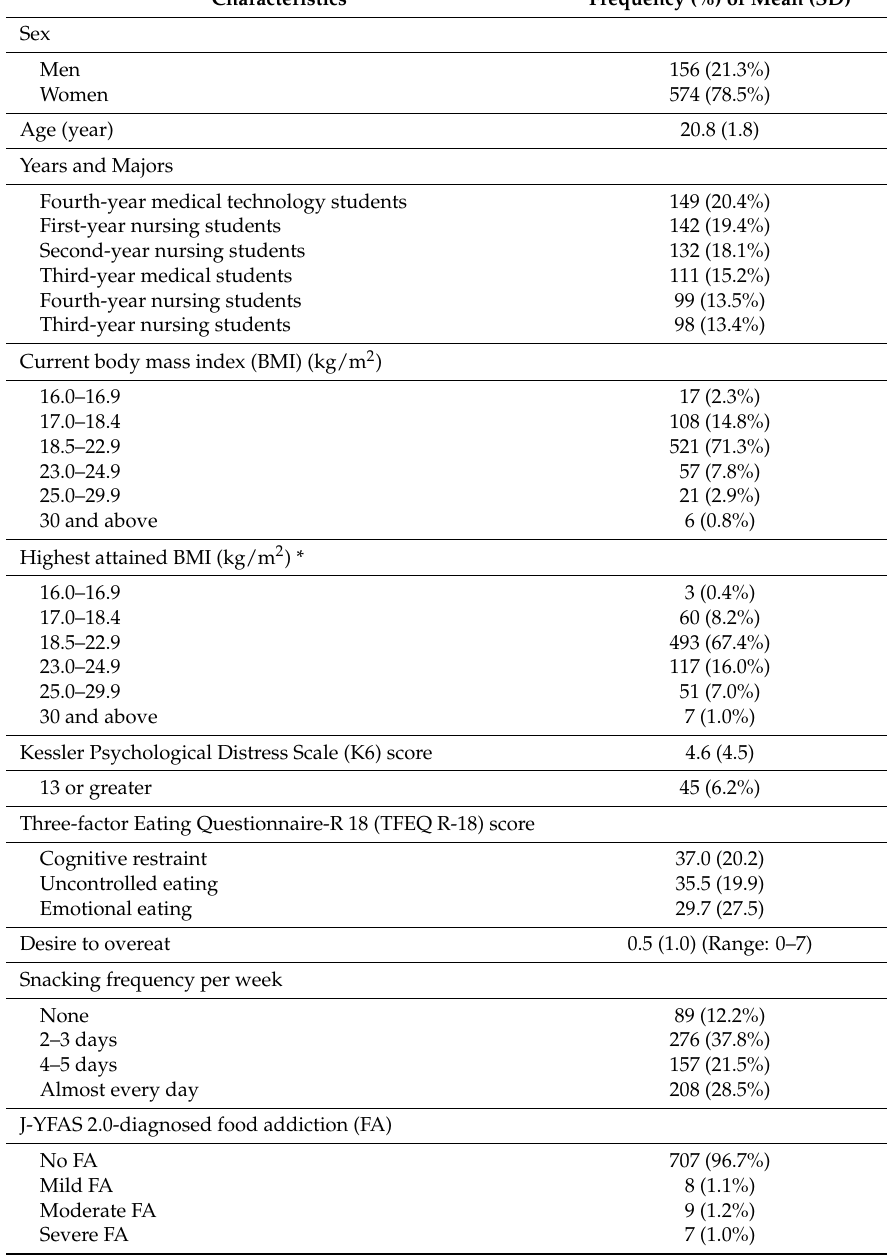
Table 1. Subject characteristics ( n =